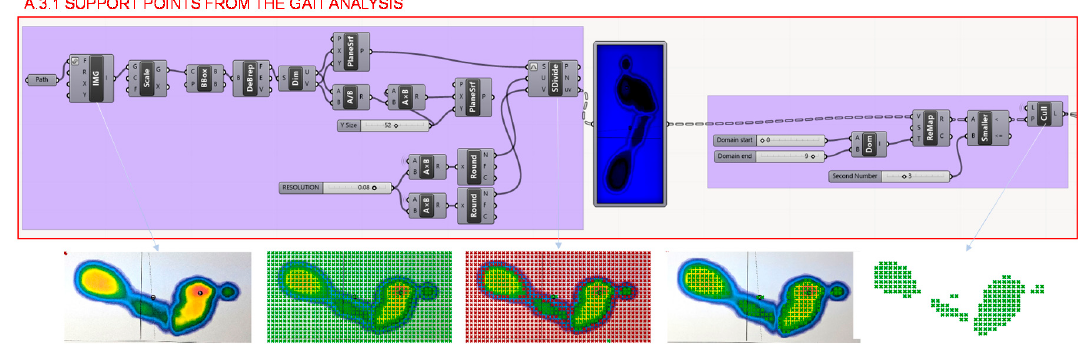
Figure 14. Programming structure definition developed to determine the support points of the foot from the gait analysis.